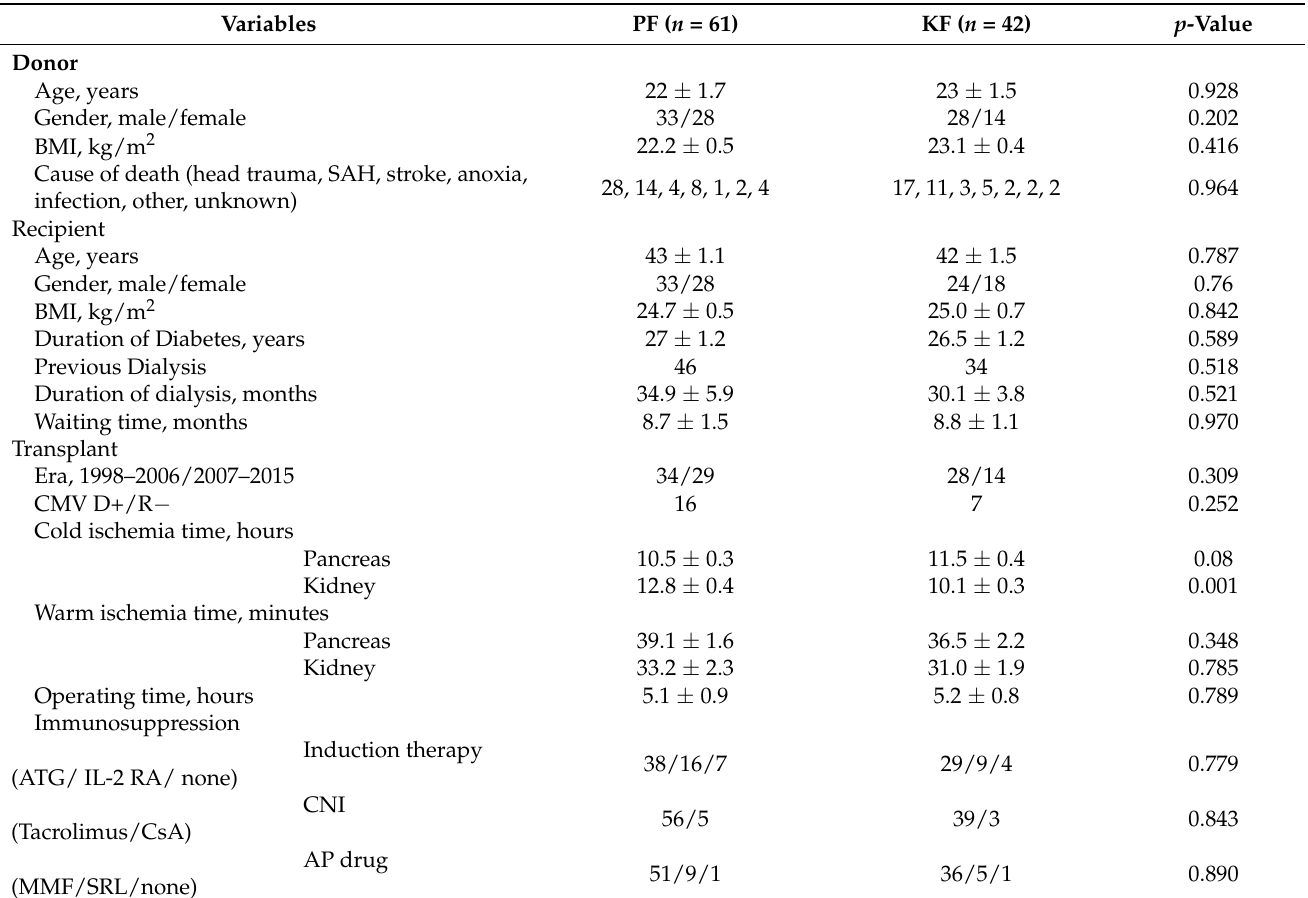
Table 1. Donor, recipient, and transplant